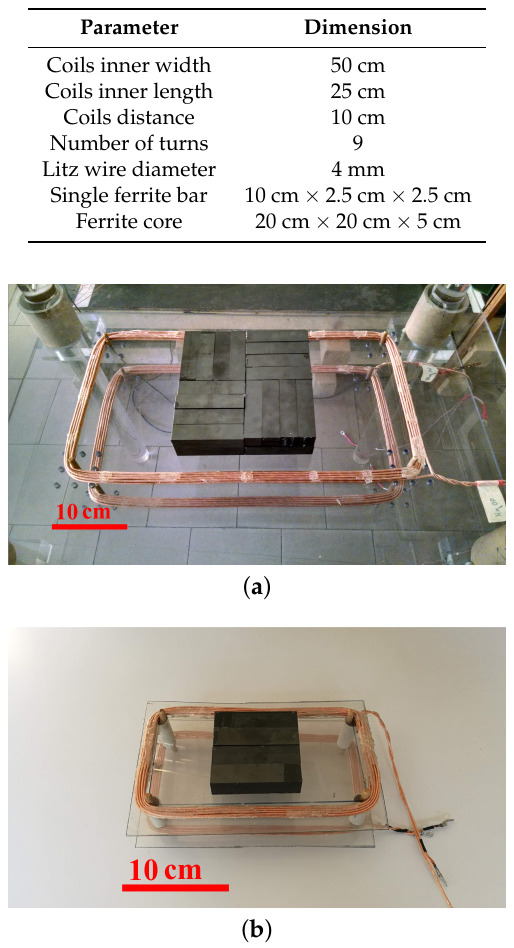
Figure 3. Tested inductive power transfer (IPT) systems. Starting system ( a ) and down-scaled one ( b